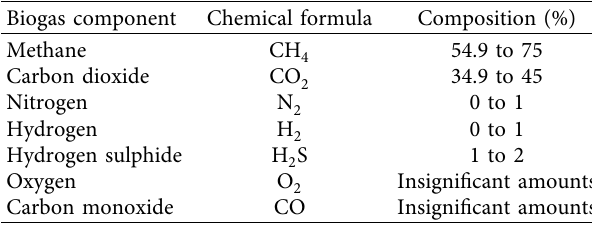
Table 1: Constituents of biogas